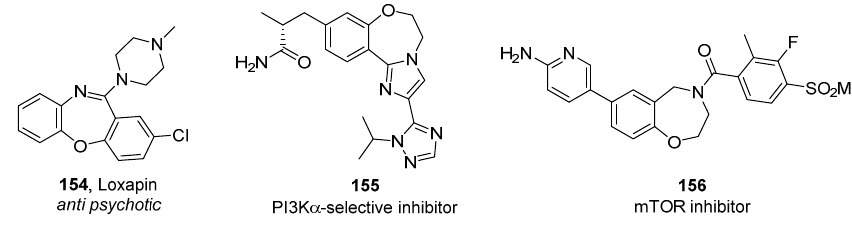
Figure 10. Examples of representative oxazepines.